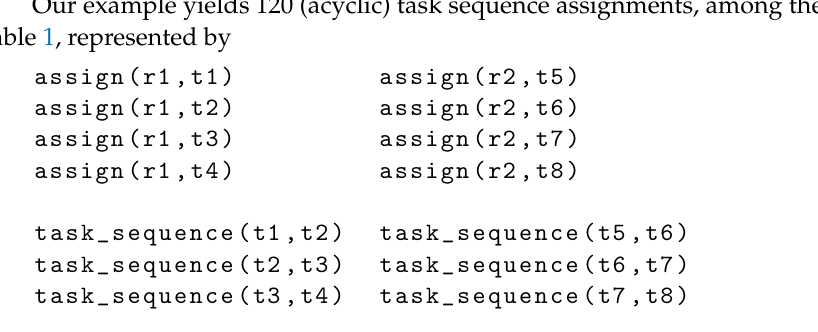
Listing 5. Acyclicity between task sequences via #edge